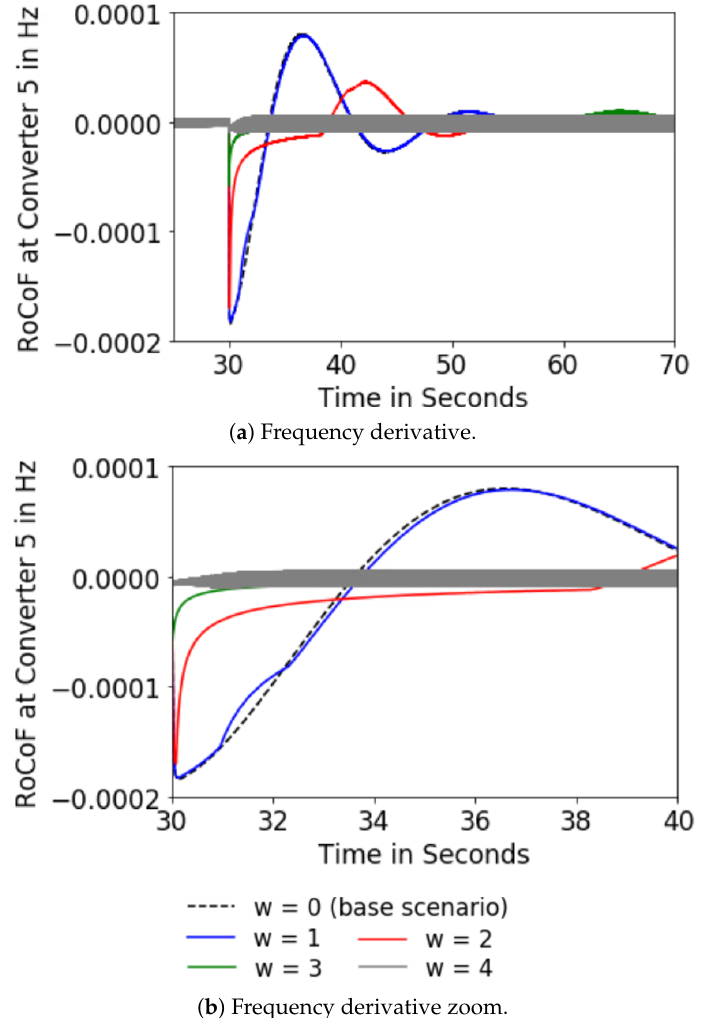
Figure 10. Frequency derivative/RoCoF scenario